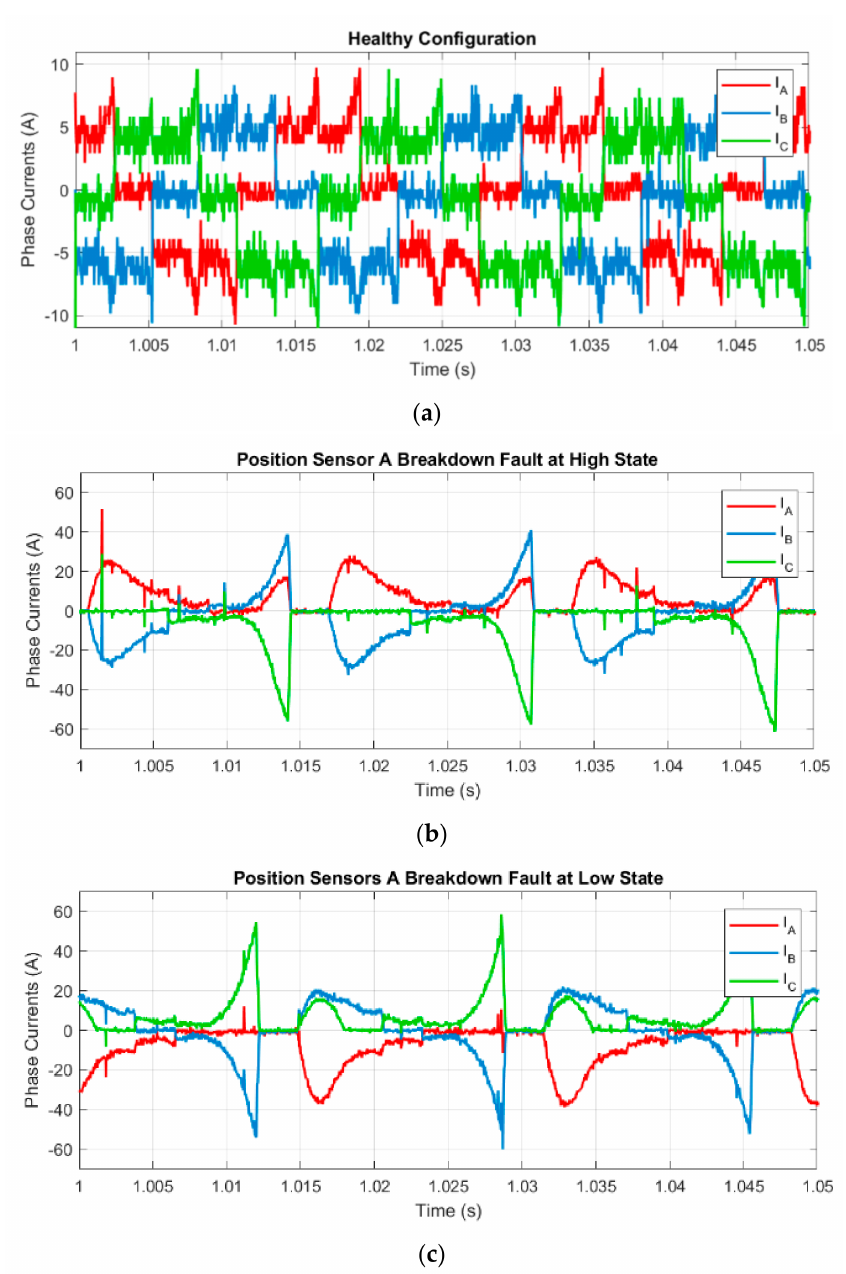
Figure 20. Experimental investigation of motor phase currents under single position sensor break- down fault. System operation at 900 rpm and no load in case of healthy and defective configurations. ( a ) Waveform of phase currents at healthy configuration; ( b ) Waveform of phase currents at defec- tive configuration of position sensor A at high state; ( c ) Waveform of phase currents at defective configuration of position sensor A at low